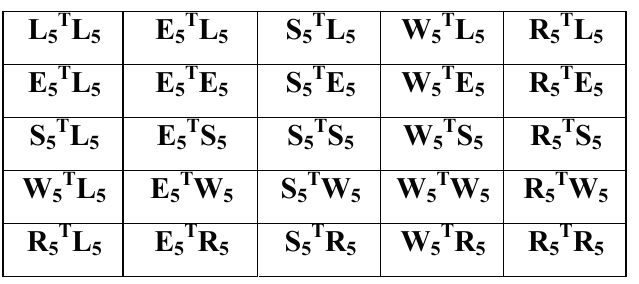
Table 7. The result list for mutual combinations of 2-D laws’